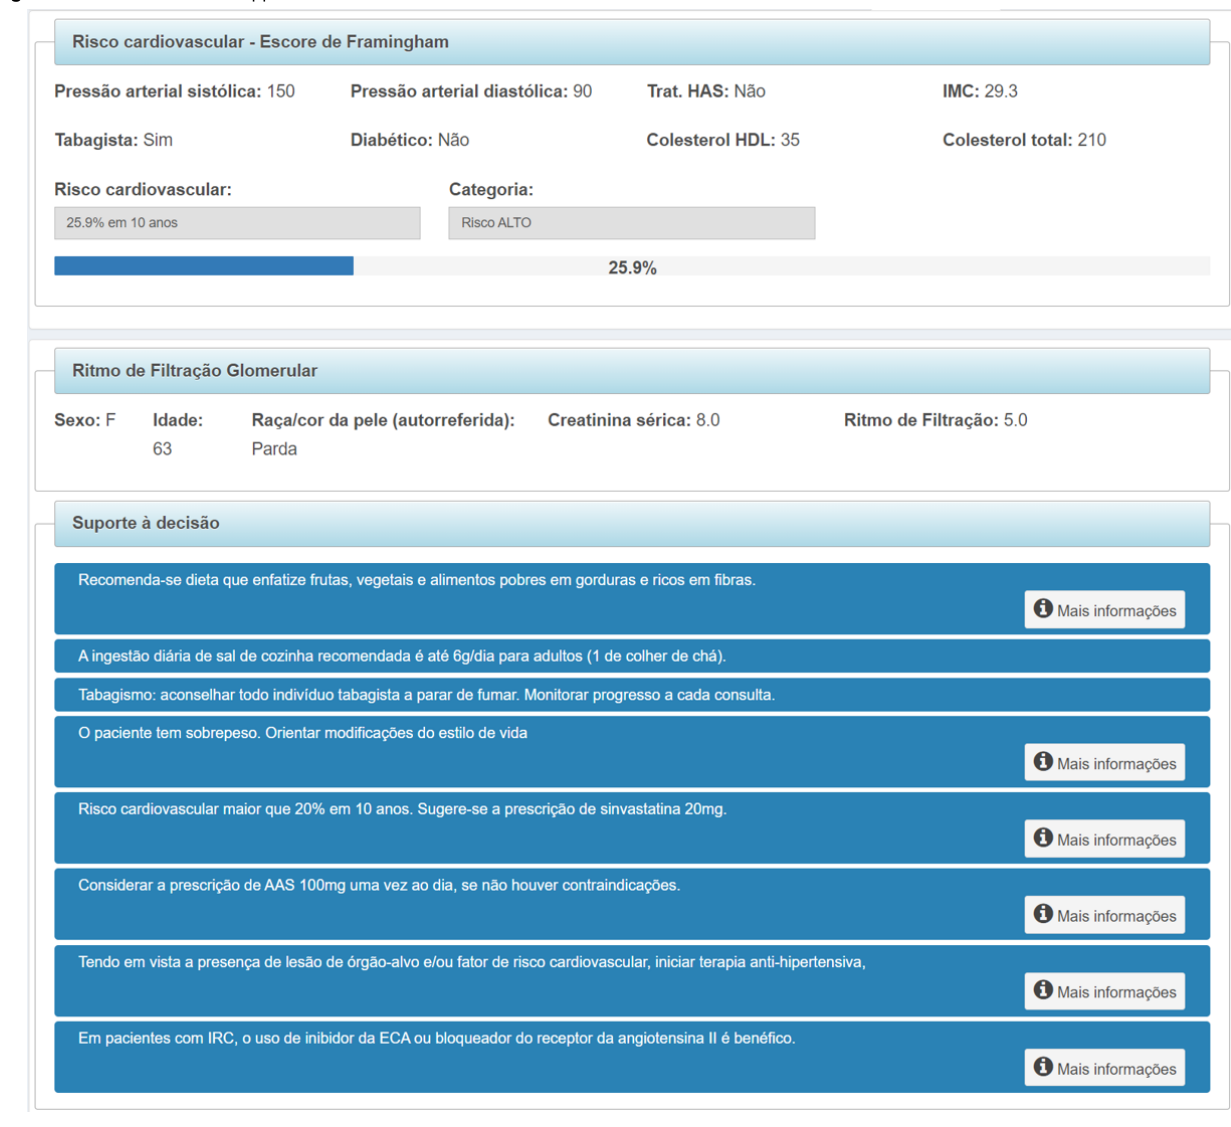
Figure 4. Clinical decision support